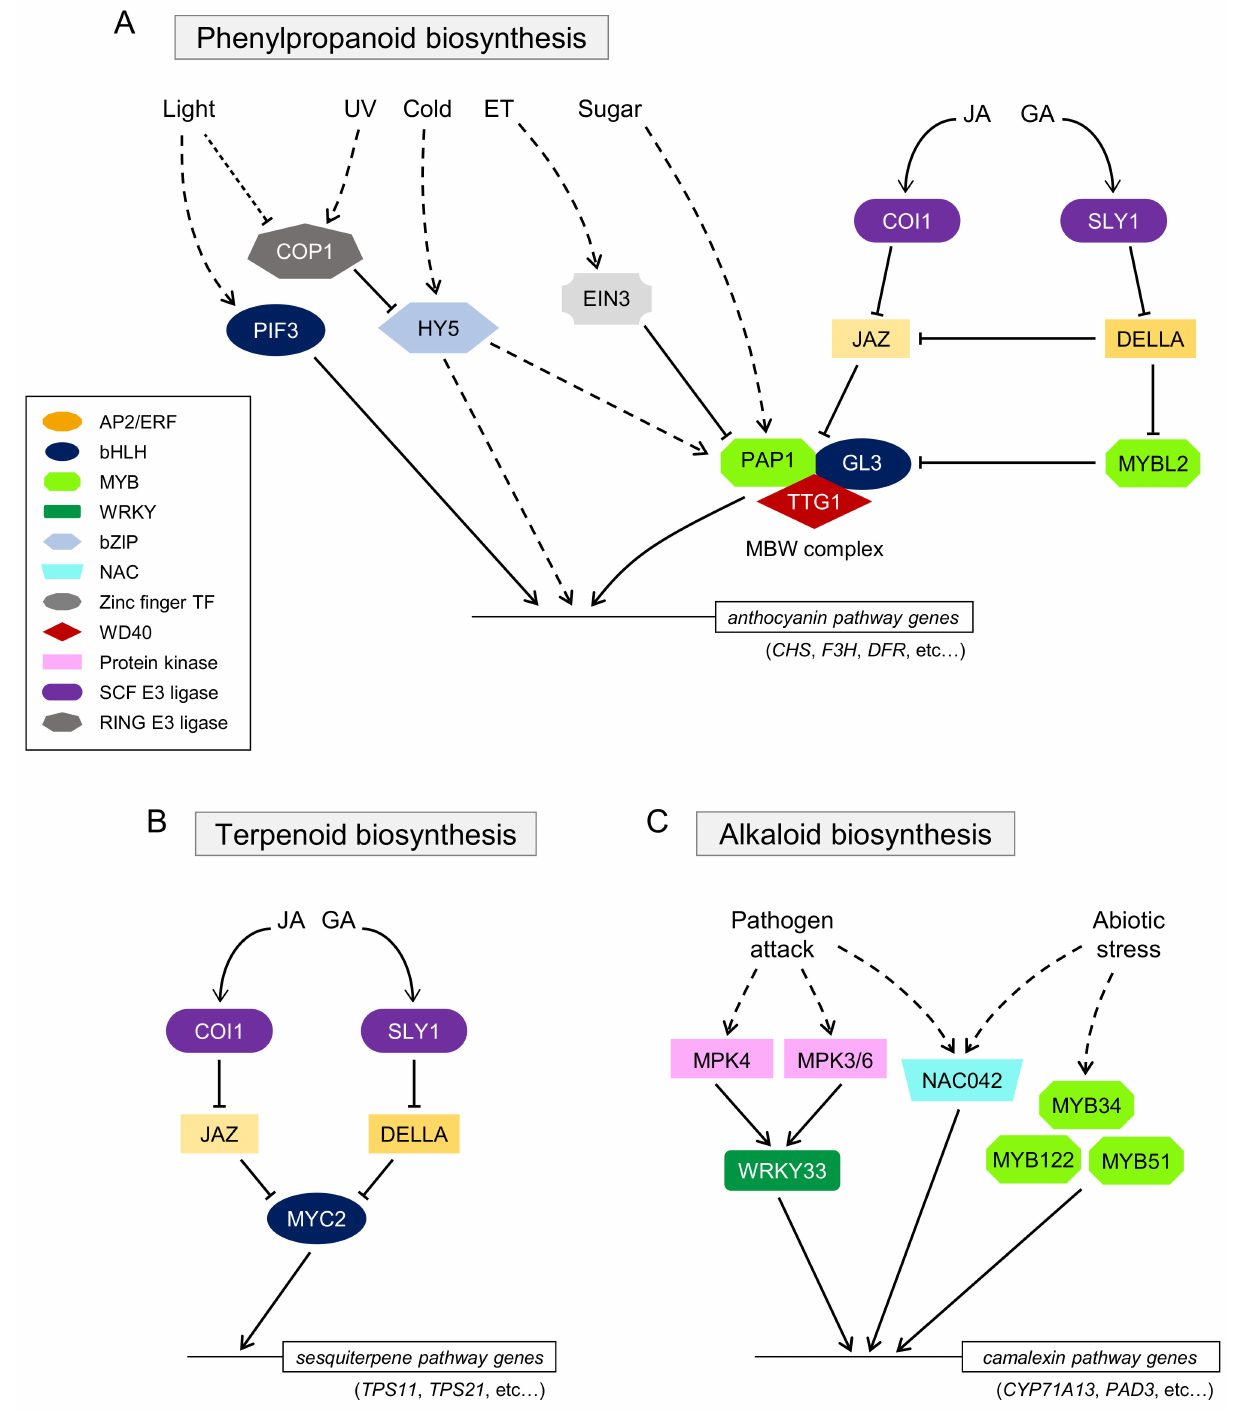
Figure 1. A brief model of the regulation of phenylpropanoid ( A ), terpenoid ( B ), and camalexin ( C ) biosynthesis in A. thaliana . Black arrows indicate upregulation, while T-shaped lines indicate inhibition. Broken lines show indirect or undetermined steps that are possibly involved in uncharacterized proteins or unidentified regulation. JAZ and DELLA include the functionally redundant proteins. Abbreviations: CHS, Chalcone synthase; COI1, Coronatine-insensitive 1; COP1, Constitutive photomorphogenesis 1; DFR, Dihydro flavonol reductase; EIN3, Ethylene-insensitive 3; ET, Ethylene; F3H, Flavanone 3-hydroxylase; GA, Gibberellin; GL3, Glabra 3; HY5, Elongated Hypocotyl 5; JA, Jasmonate; JAZ, Jasmonate ZIM domain; MBW, MYB–bHLH–WD40; MYBL2, MYB-LIKE2; PAD3, Phytoalexin-deficient 3; PAP1, Production of Anthocyanin Pigment 1; PIF3, Phytochrome-interacting factor 3; TPS, terpene synthase; TTG1, Transparent Testa Glabra 1; SLY1, Sleepy